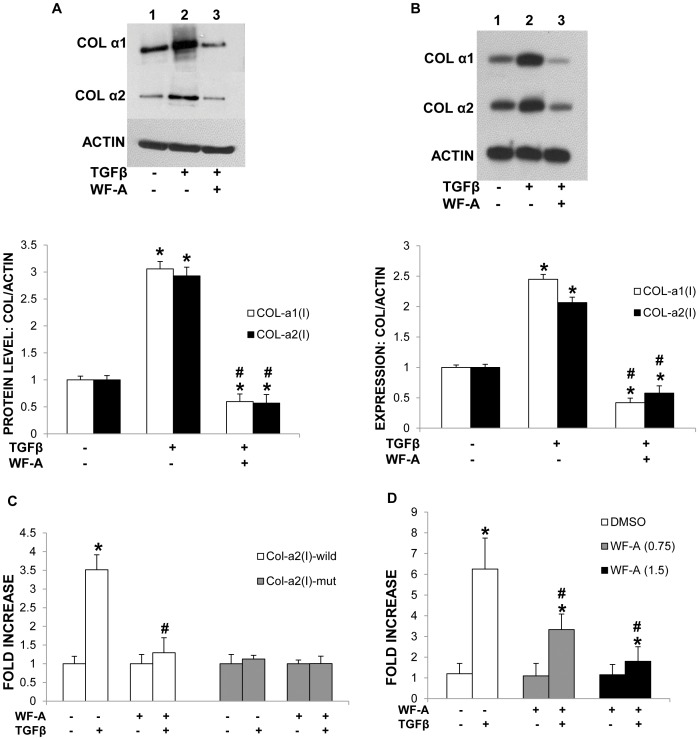
WF-A inhibits TGF-β1 induced expression of type I collagen.A. WF-A inhibits TGF-β1 induced increase in collagen polypeptides. HLFs were treated with DMSO (lanes 1 and 2) or 1.5 µM WF-A (lane 3) for 1 h and then treated with TGF-β1 (lanes 2 and 3) for 24 h. Expression of collagen α1(I) (COLα1) and collagen α2(I) (COLα2) polypeptides in cell lysates was measured by Western blot. Loading control: actin. Bottom panel: levels of collagen α1(I) and α2(I) polypeptides were normalized to that of actin and plotted from three independent experiments. The error bars represent ±1 SEM. B. WF-A inhibits induction of collagen mRNAs by TGF-β1. Experiment as in A, except collagen mRNAs were analyzed by RT-PCR. Loading control: actin. Bottom panel: levels of collagen α1(I) and α2(I) mRNAs were normalized to that of actin mRNA and plotted from three independent experiments. The error bars represent ±1 SEM. C. WF-A inhibits transcriptional activation of collagen α2(I) promoter. Luciferase reporter gene containing wild type collagen α2(I) promoter (open bars) or collagen α2(I) promoter with the mutated TGF-β1-responsive element (black bars) were transfected into HLF. After treatment with WF-A and TGF-β1, luciferase activity was normalized to the co-transfected internal control gene β-GAL. The plot is from three independent transfections performed in duplicate. Error bars represent ±1 SEM. D. WF-A inhibits transcriptional activation of a SMAD responsive promoter. Experiment as in C, except reporter gene containing (CAGA)12MLP promoter was used and WF-A was used at concentrations 0.75 µM (gray bars) and 1.5 µM (black bars). * represents p<0.05 and # represents p<0.01.